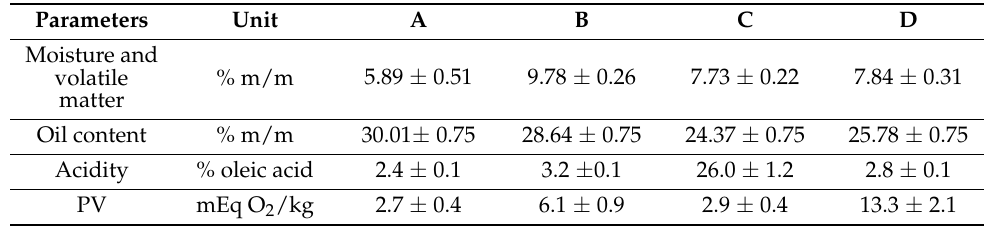
Table 4. Chemical composition of B. mori pupae.